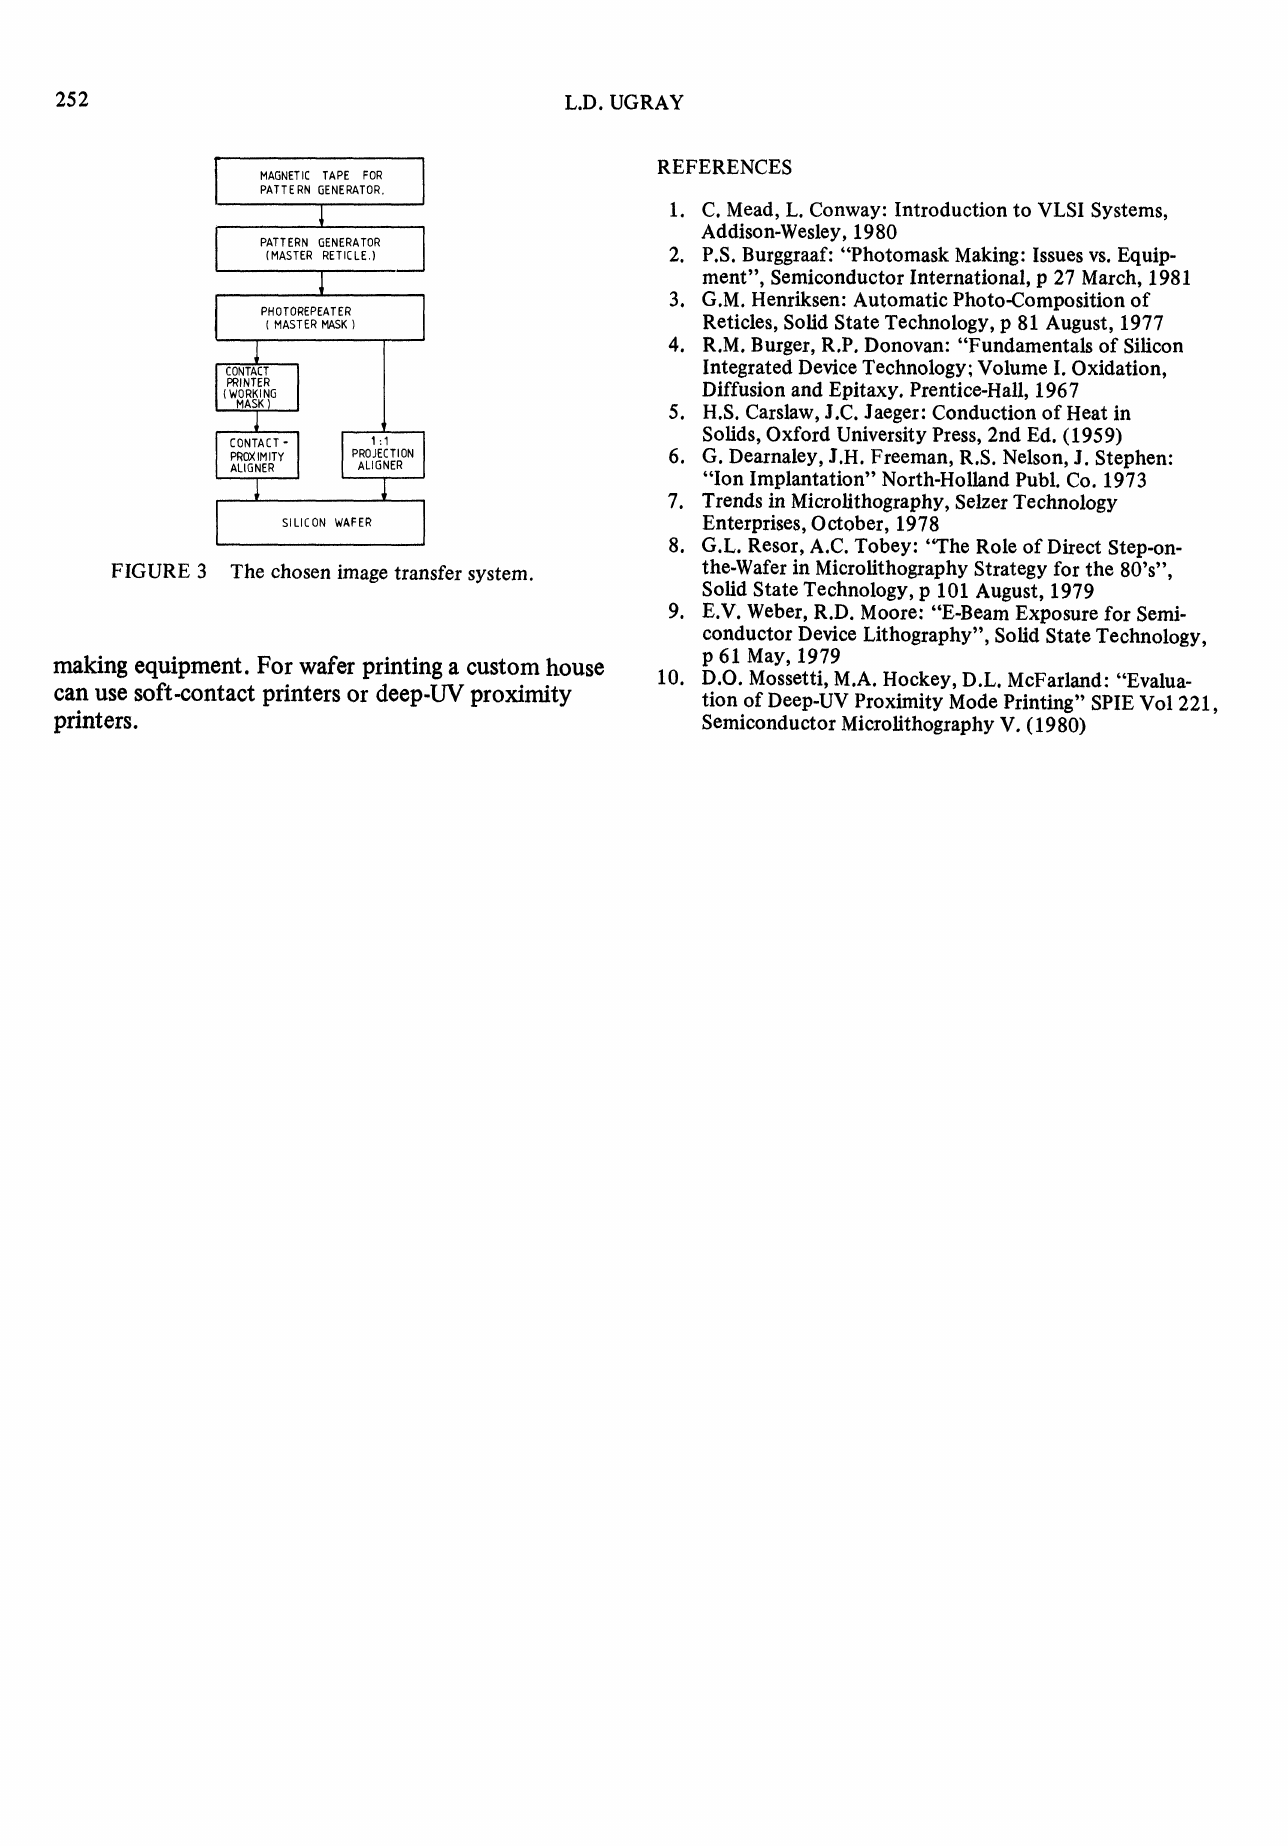
PATTERN fiENERATOR (MASTER RETICLE.)